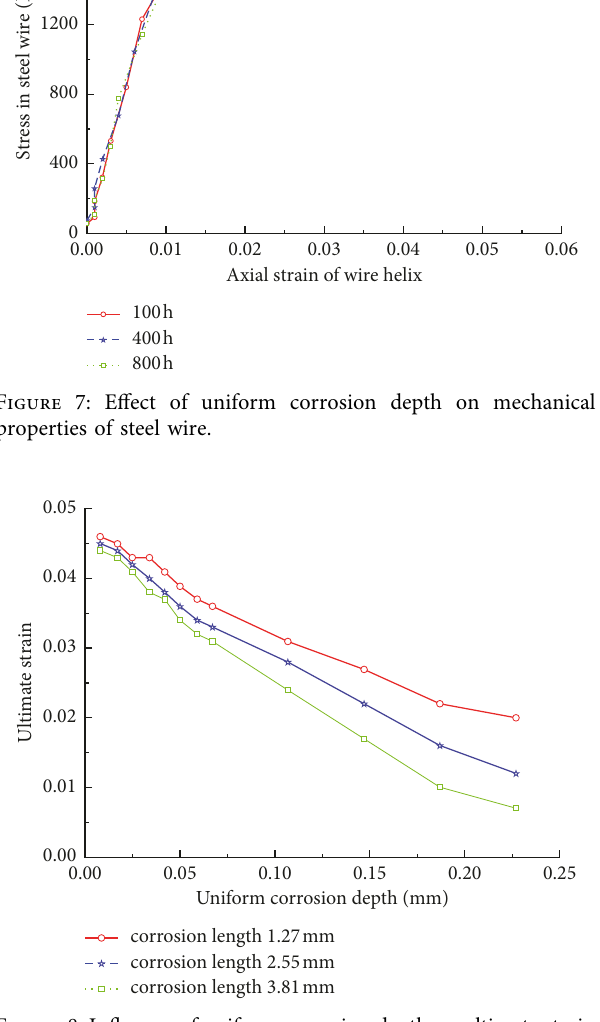
Figure 10: Influence of uniform corrosion depth on ultimate strain of steel wire.